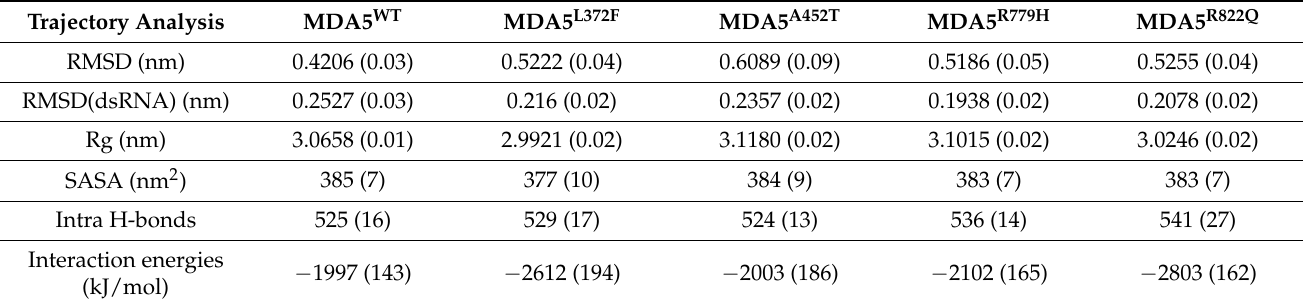
Table 1. Summary of trajectory analysis results of MDA5 WT , MDA5 L372F , MDA5 A452T , MDA5 R779H , and MDA5 R822Q simulations. Standard deviations are given in the